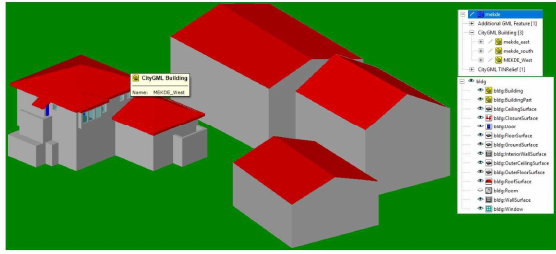
Figure 2. MIRC’s three Buildings (in